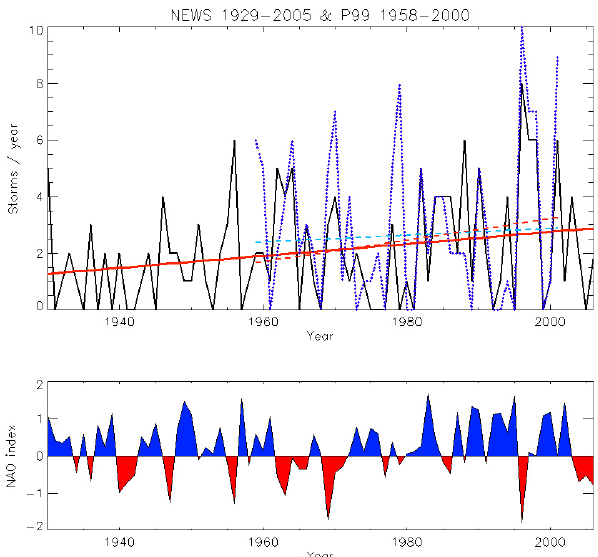
Fig. 5. Series of storms from newspaper records (black solid line), percentile 99 of instrumental records (blue dotted line) when wind comes from 195–285 degrees. Trend lines for news series in red for the whole period and for the instrumental period and in blue for the instrumental series (solid line means significant – p < 0 . 05 – and dashed line means not significant). Evolution of the winter NAO index in the lower panel.